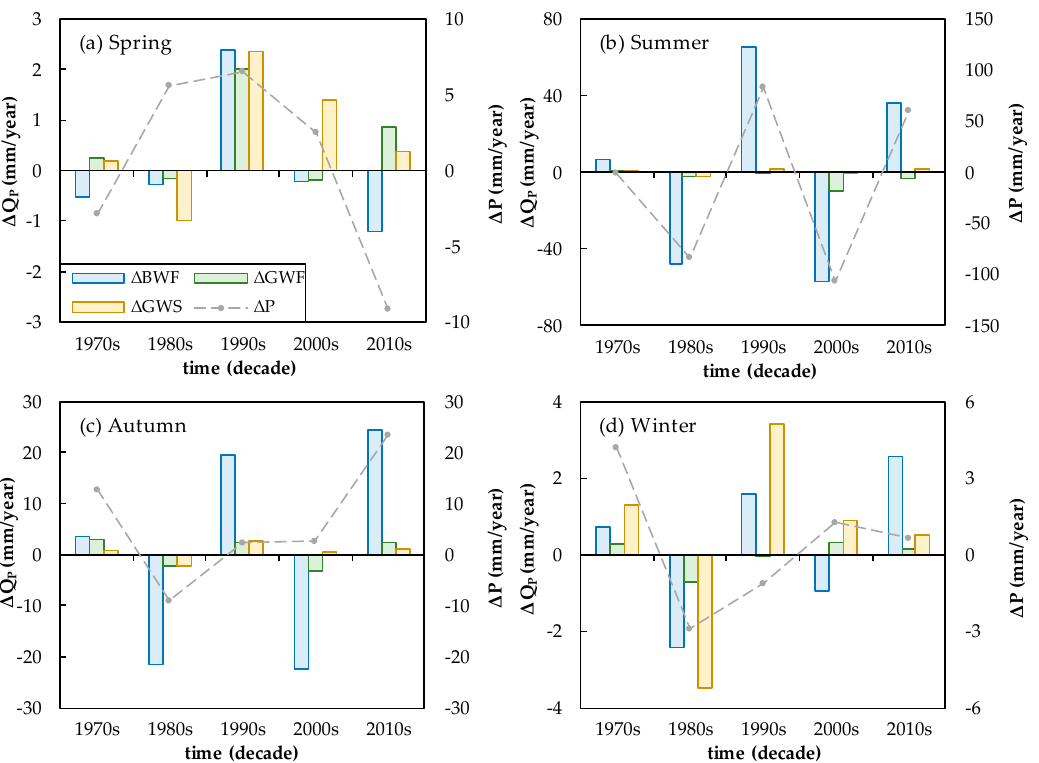
Figure 7. Changes in seasonal hydrological components impacted by precipitation.